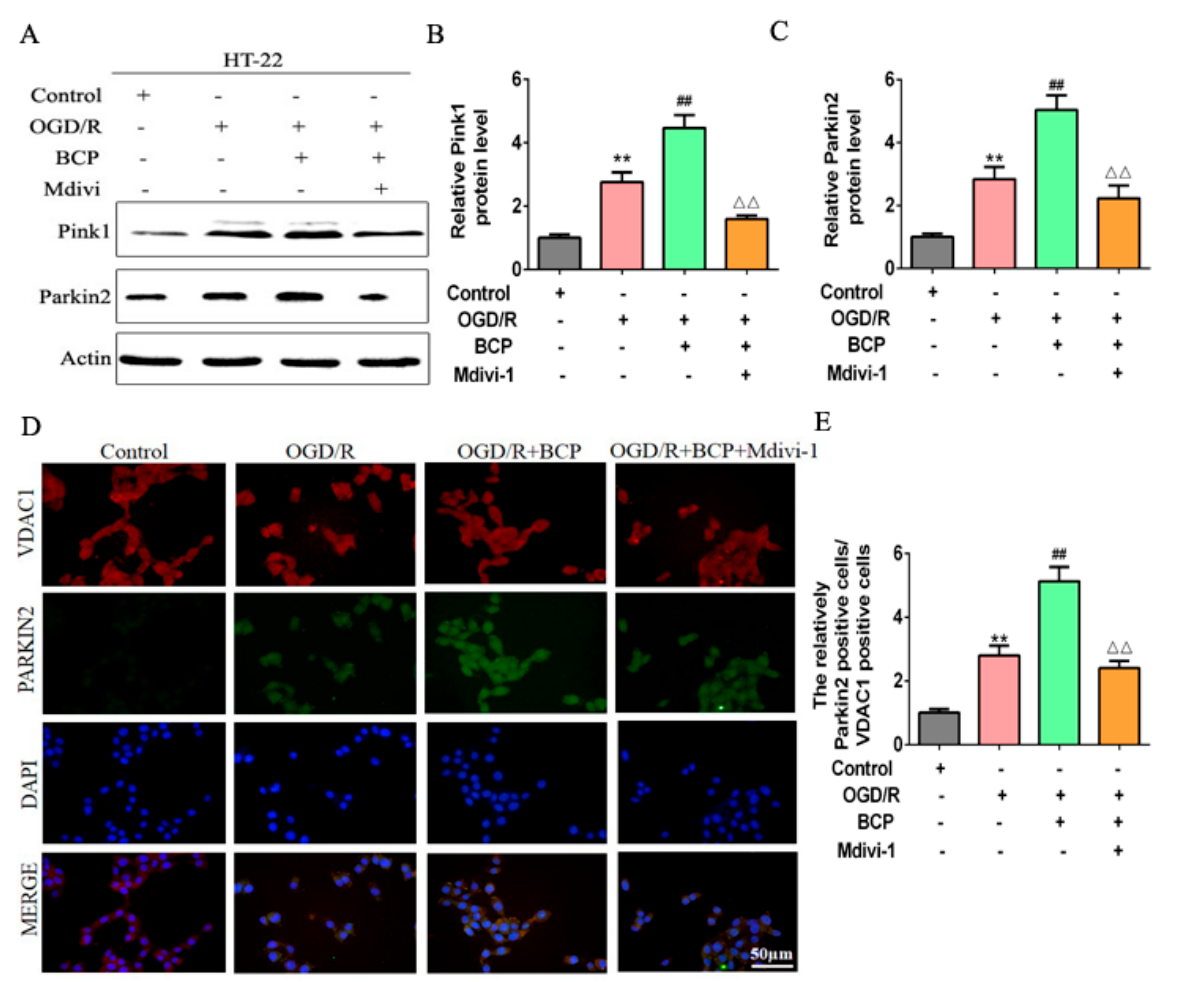
Figure 7. Pink1/Parkin2 pathway-dependent mitophagy is implicated in BCP-induced mi- tophagy. ( A – C ) Representative Western blots showing protein levels of Pink1 and Parkin2 af- ter treatment with the mitophagy inhibitor Mdivi-1. Protein levels were normalized to β -actin. ( D , E ) Double-immunofluorescence staining for VDAC1 and Parkin2 in HT-22 cells after treatment with Mdivi-1. VDAC1 (red) and Parkin2 (green) double-stained cells (yellow) indicate mitophagy. (Scale bar = 50 µ m, 400 × magnification). ( n = 3; ** p < 0.01 OGD/R group vs. control group; ## p < 0.01 OGD/R + BCP group vs. OGD/R group; (cid:52)(cid:52) p < 0.01 Mdivi-1 group vs. BCP